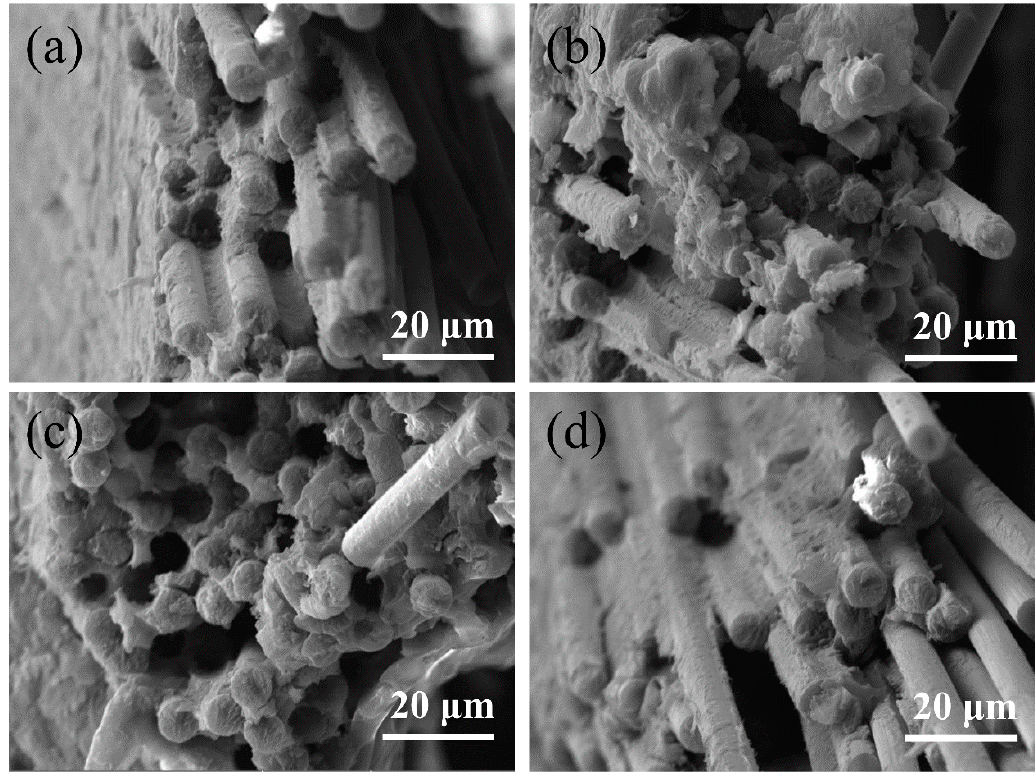
Figure 6. Longitudinal tensile fracture of CF/PEEK unidirectional plates at different isothermal temperatures: ( a ) 290 °C; ( b ) 300 °C; ( c ) 310 °C; ( d ) 320 °C.